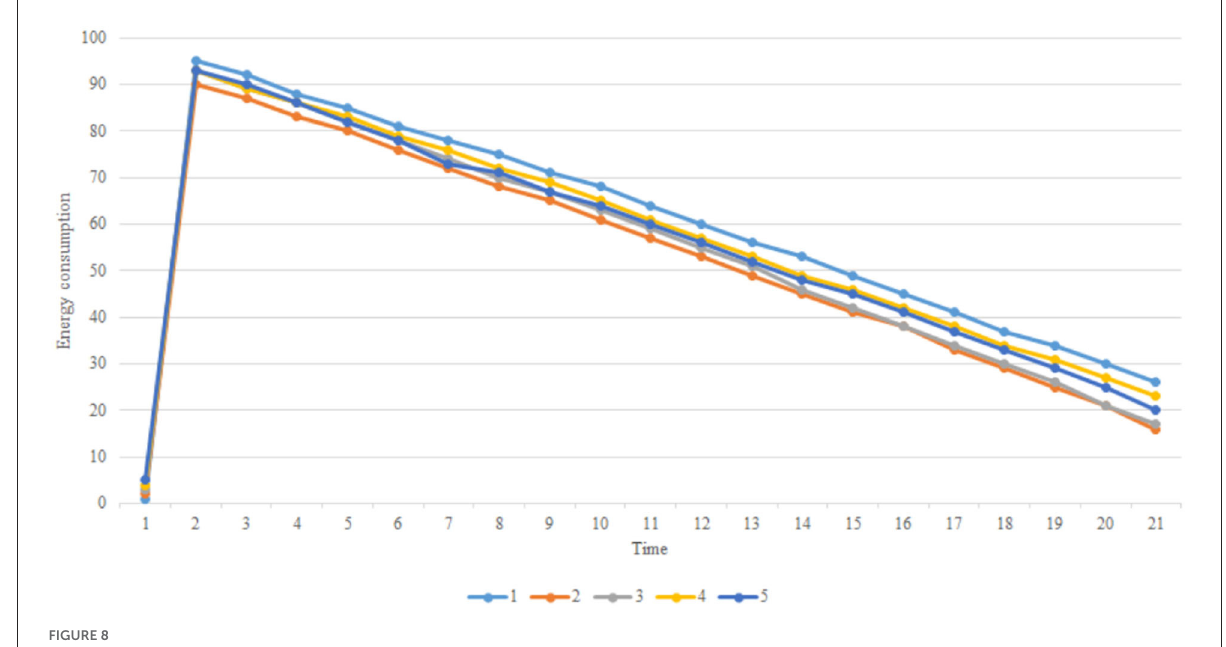
FIGURE8 Aerial camera energy